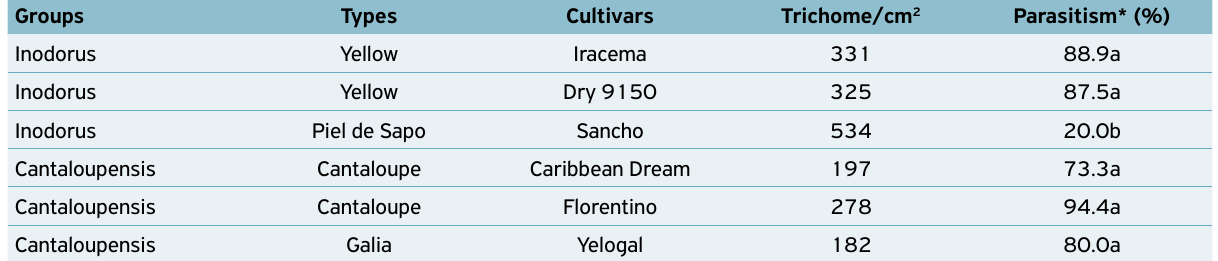
Table 1. Trichome density and parasitism in Liriomyza sativae larvae by Opius scabriventris on leaves of different melon cultivars.